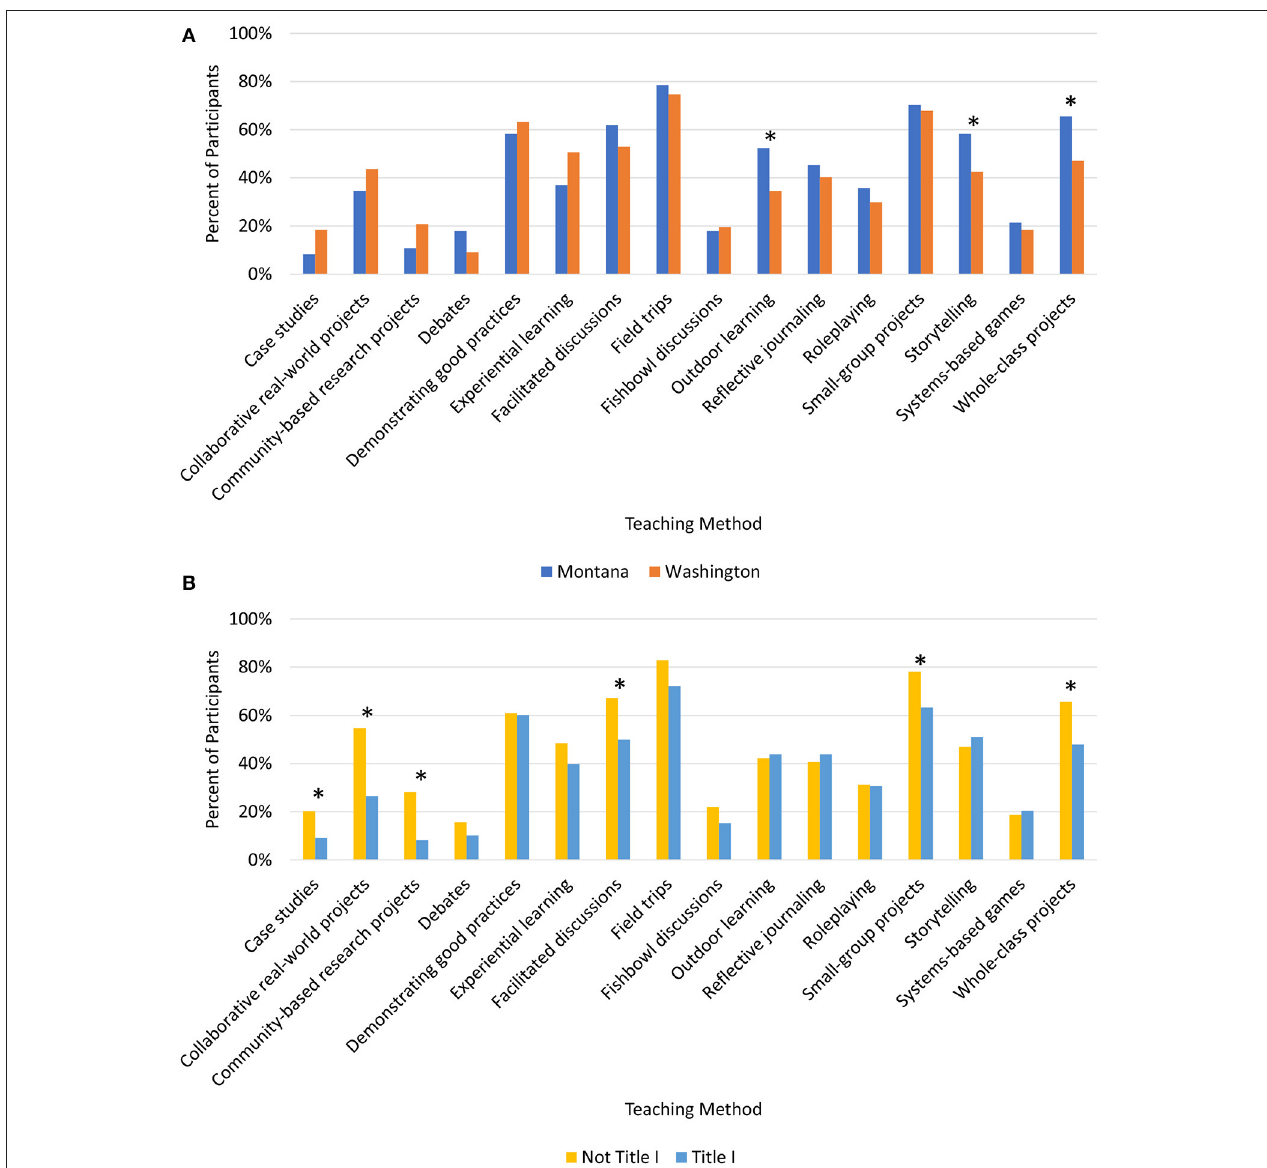
FIGURE 1 | The percent of participants in (A) Washington ( n = 87) and Montana ( n = 84) and in (B) Title I ( n = 98) and non-Title I ( n = 64) schools that use each teaching method in their classrooms. Asterisks represent significant differences. Case studies were described to teachers as “in-depth looks at particular people situations, or groups,” and systems-based games were described to teachers as “(games that allow students to see the interconnectedness of different